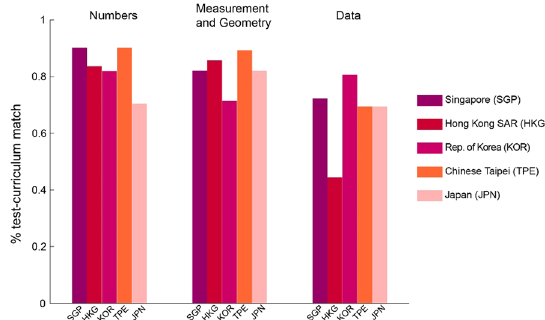
Fig. 6 Match between TIMSS 2019 assessment items and